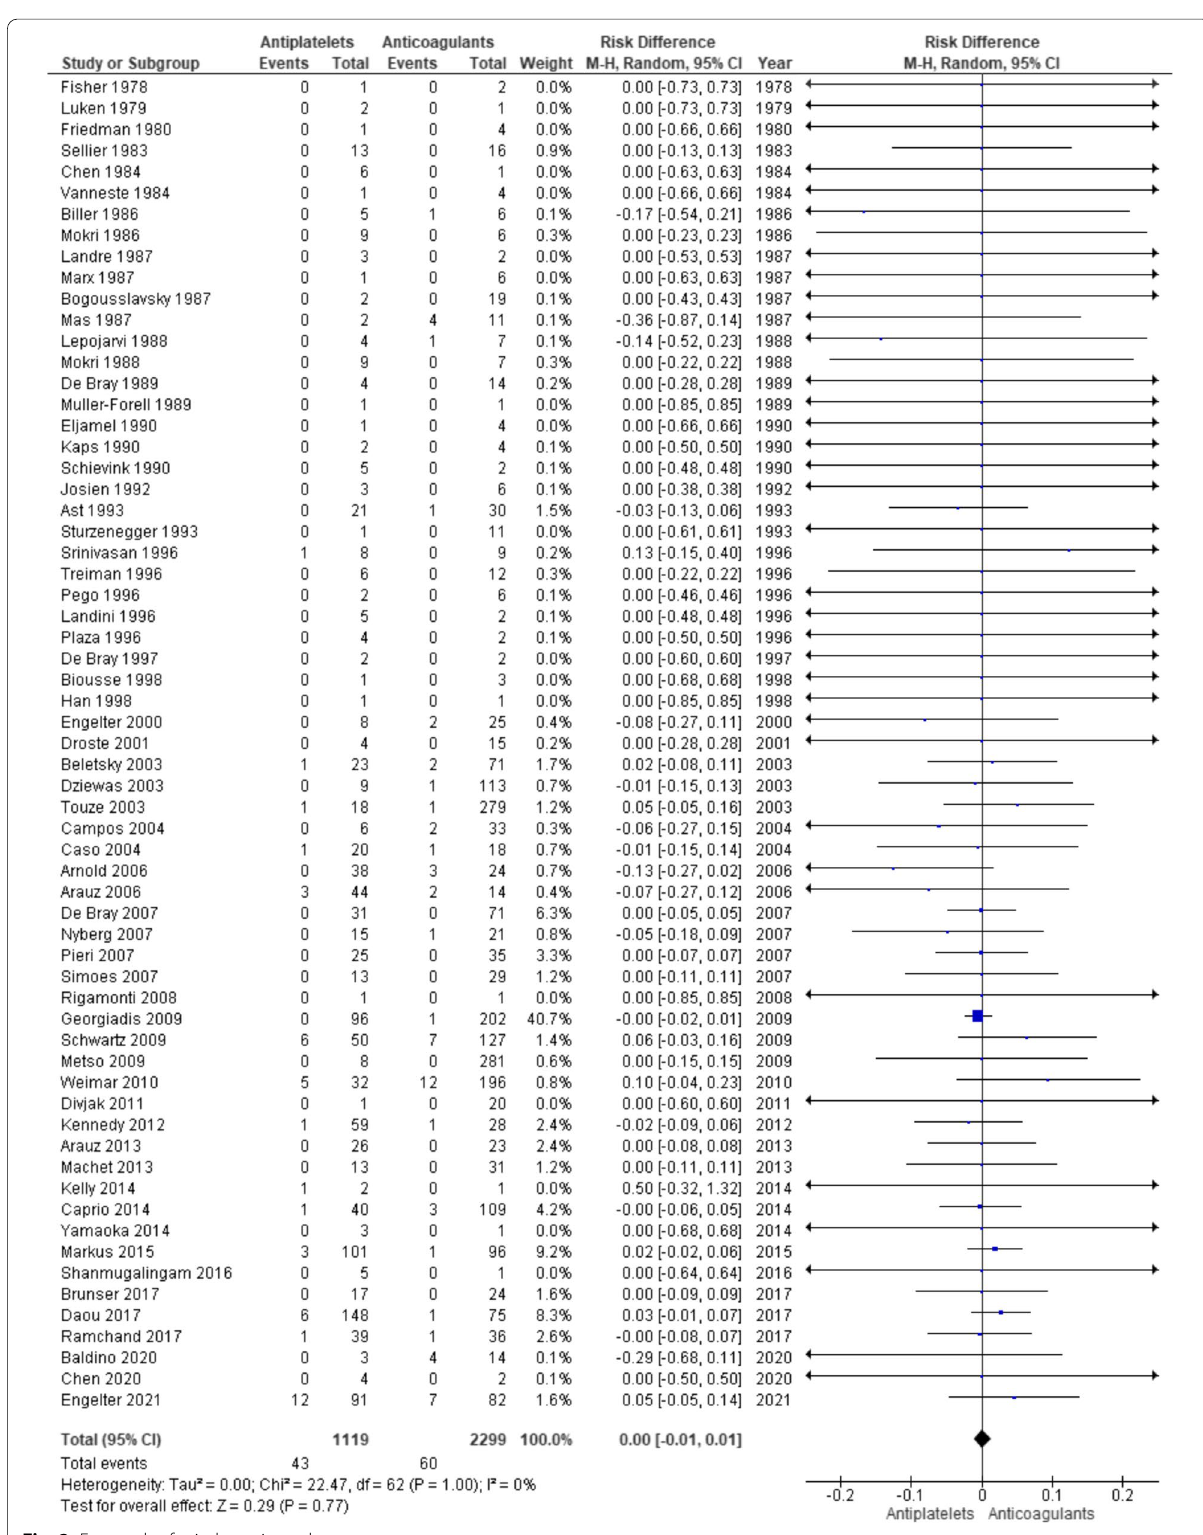
Fig. 2 Forest plot for ischaemic stroke